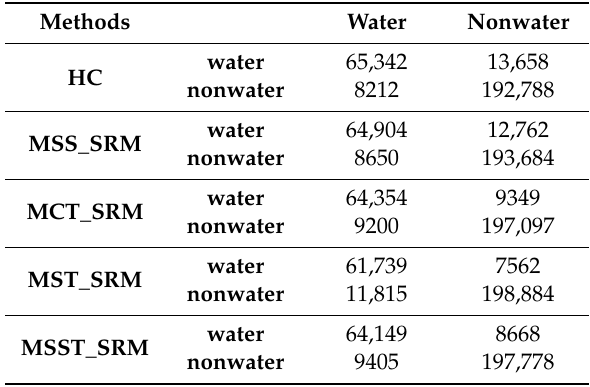
Table 3. Confusion matrices of the di ff erent methods for Daye Lake.